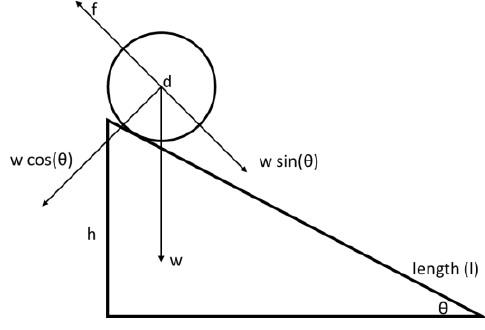
Figure 1. Diagram showing forces of the rolling body.